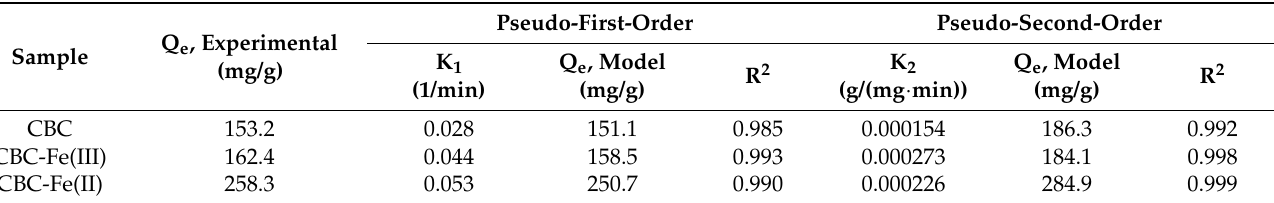
Table 2. Kinetic models parameters for RhB adsorption by CBC, CBC ‐ Fe(III) and CBC ‐ Fe(II).